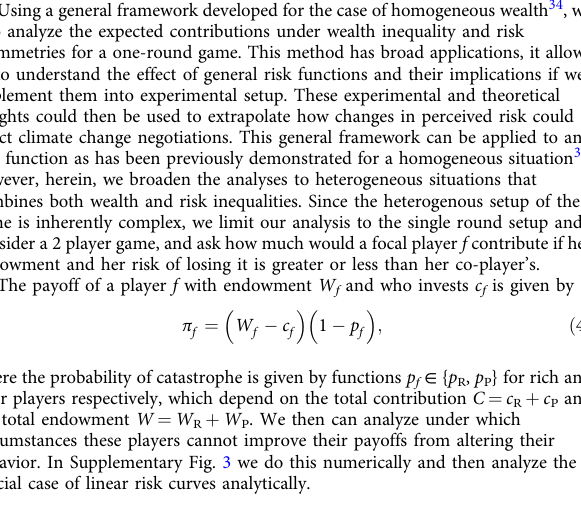
Table 1 Evolutionary stable state c (cid:4) P and c (cid:4) R for a decreasing linear risk curve for the rich λ R calculated by